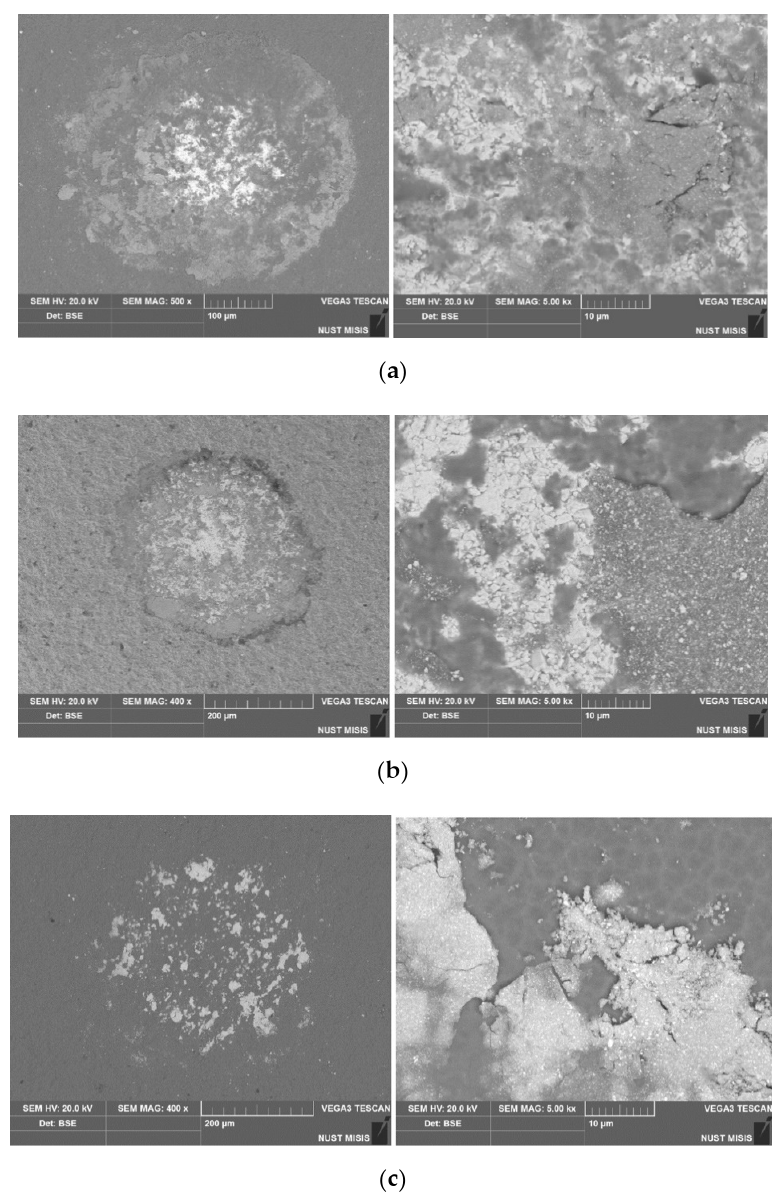
Figure 8. SEM micrographs of impact cavities after testing in air at an applied load of 250 N for 5 × 10 5 cycles: ( a ) Ti–Al–N; ( b ) Ti–Al–Cu–N; and ( c ) Ti–Al–Ni–N coatings.